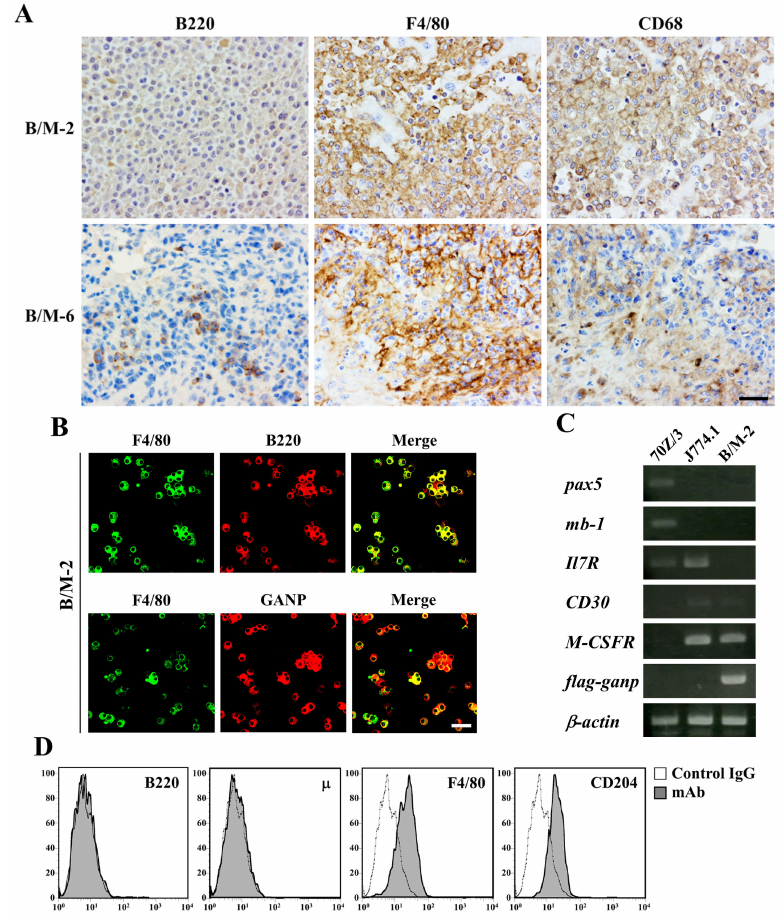
Figure 3. B-cell lineage and macrophage markers in lymphomas in Ig - ganp Tg mice. ( A ) Immunocytochemical staining of B / M-2 and B / M-6 cells. Both B-cell lineage marker B220 and macrophage markers F4 / 80 and CD68 are copositive. Scale bar = 20 µ m. ( B ) Cytological immunofluorescence on B / M2 cell line. The macrophage marker F4 / 80, B-cell lineage marker B220, and GANP are colocalized. Scale bar = 20 µ m. ( C ) Expression of various transcripts related to B cells ( pax5 , mb-1 , and Il7R ) and macrophages ( CD30 and c-fms ) in B / M-2. 70Z / 3 and J774.1 are used as controls for B cells and macrophages, respectively. Exogenous ganp transcripts are detected using flag - and ganp -specific polymerase chain reaction primers. β -Actin was used as a loading control. ( D ) Surface expression of various markers on B / M-2. These data collectively suggest that B220 is expressed not on the surface but in the cytoplasm. All data are representative of three independent